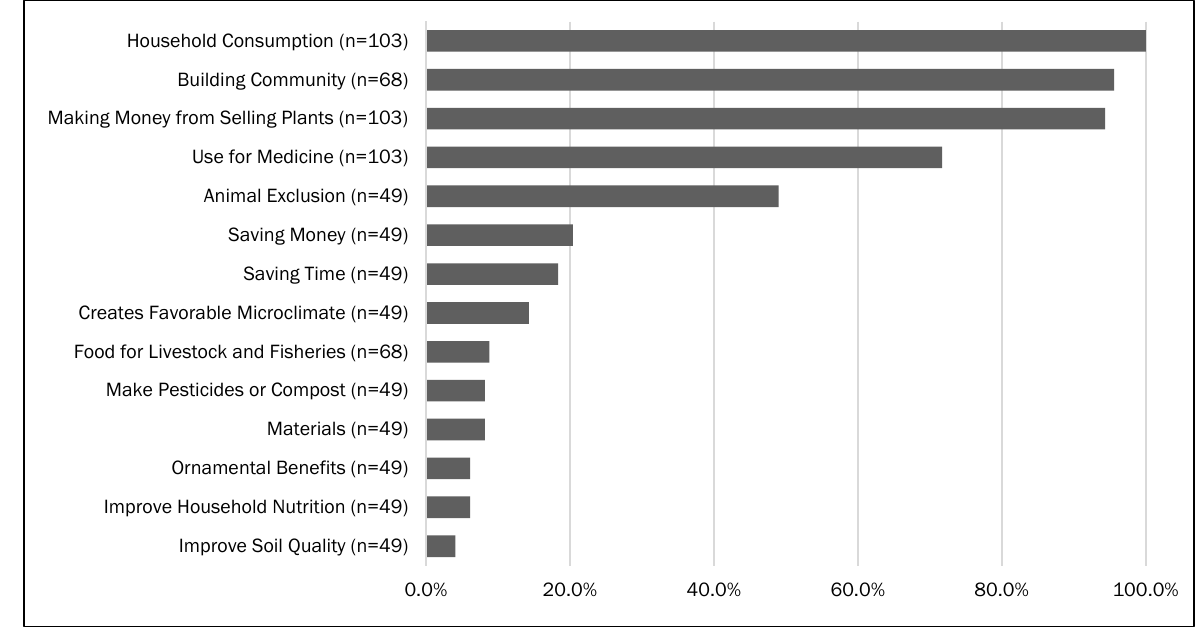
Figure 3. Reported Benefits of Wild